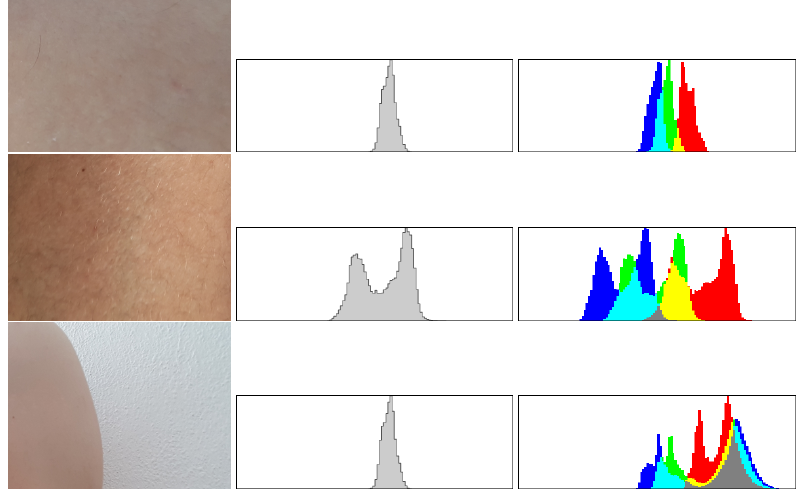
Figure 6. If the analysis of histograms shows that the cluster presents normal skin the images is not forwarded to evaluation phase. In the rows 1–2 we see examples of regular healthy skin and in the last one a fragment of a skin over a wall. The images show a cluster and both histograms, since there are no suspicious nevi therefore all without blurring necessary for evaluation